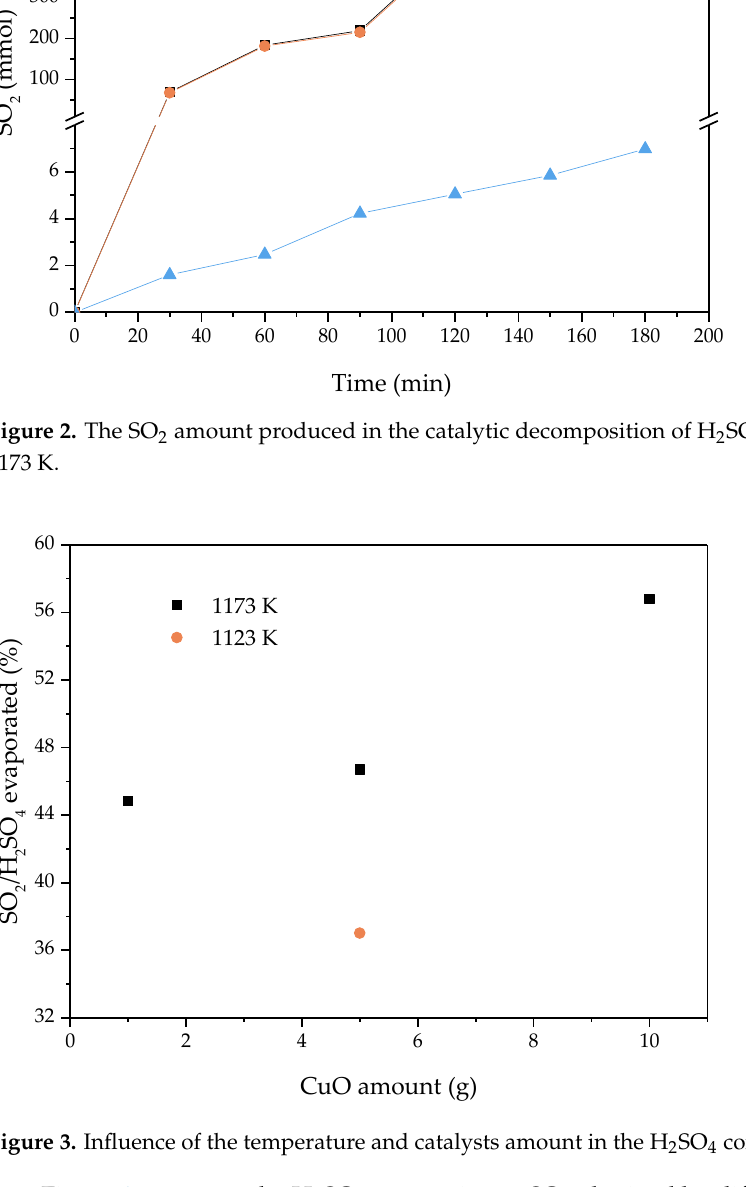
Figure 3. Influence of the temperature and catalysts amount in the H 2 SO 4 conversion to SO 2 .